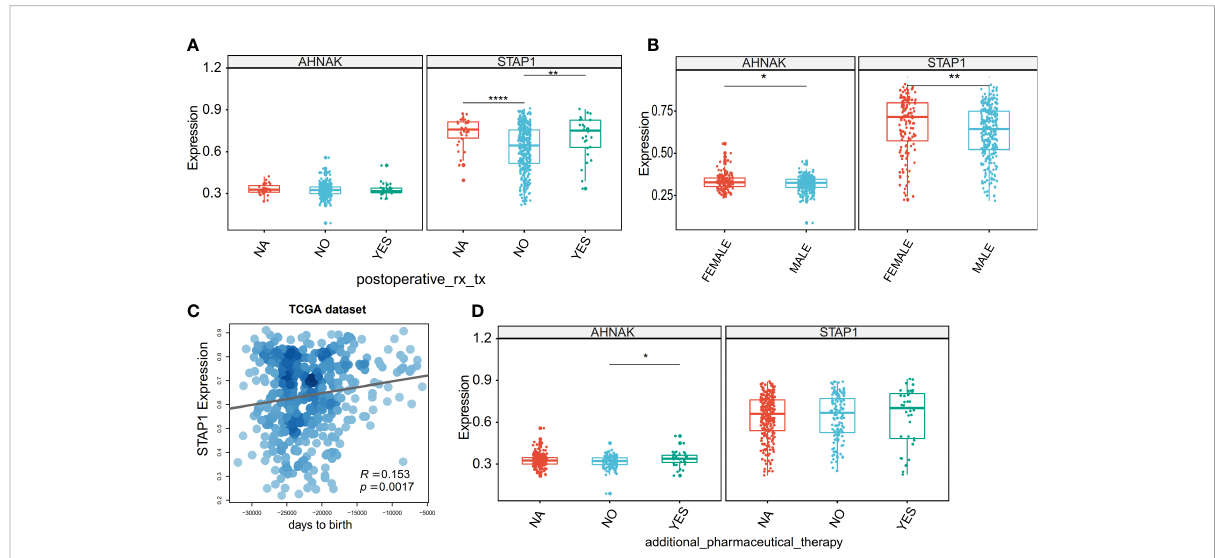
FIGURE 6 Association between the methylation level of STAP1 or AHNAK and clinical characteristics in The Cancer Genome Atlas data. (A) Difference of STAP1 and AHNAK methylation between whether postoperative rx tx. (B) Difference of STAP1 and AHNAK methylation between different genders. (C) Correlation of STAP1 methylation with ages. (D) Difference of STAP1 and AHNAK methylation between whether additional pharmaceutical therapy was used or not. *P < 0.05, **P < 0.01, ****P < 0.0001.